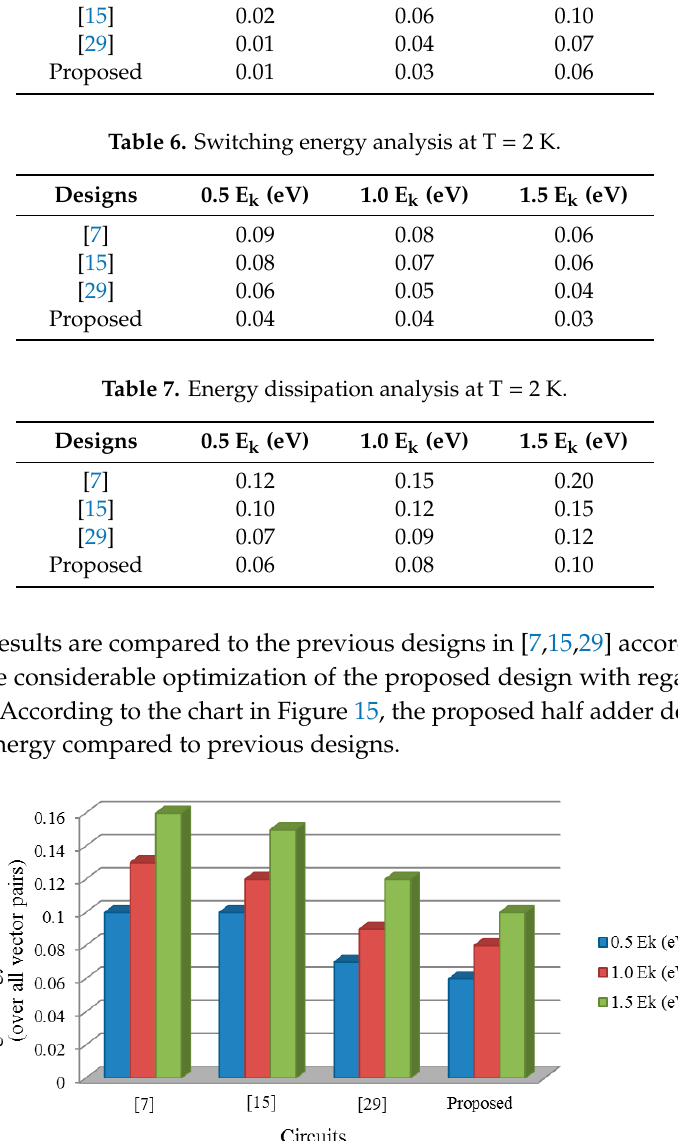
Table 5. Leakage energy analysis at T = 2 K.